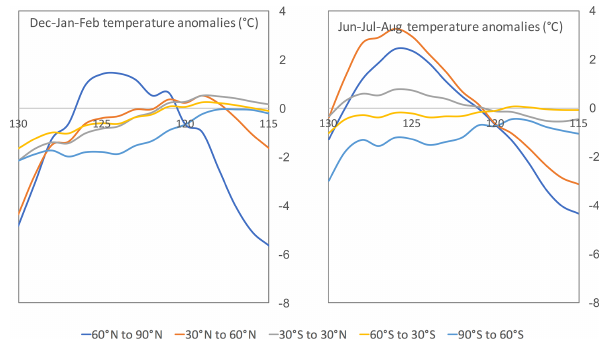
Figure 6. Emulated Last Interglacial temperature anomalies with respect to pre-industrial temperatures. An emulator was built 10 times, and the mean prediction time series of each emulator are plot- ted. Data are provided for December–January–February and June– July–August averaged over five latitude bands; cf. Figs. 2 and 3 of Bakker et al.